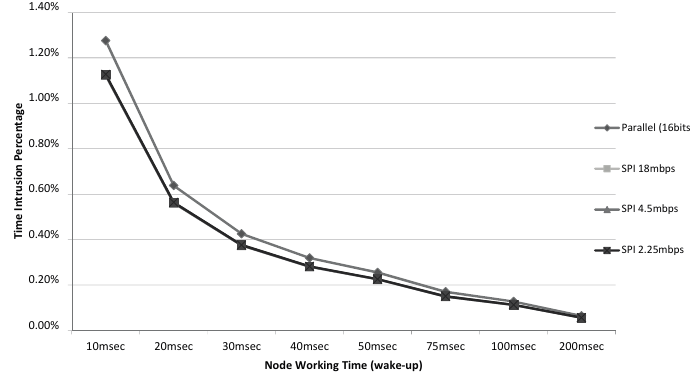
Figure 8. Percentages of time intrusion (128 bits/4 event